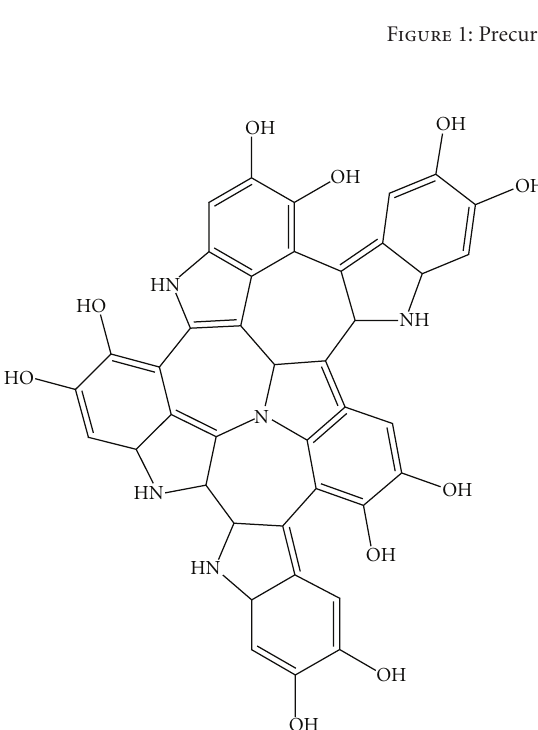
Figure 2: Model of DHI melanin oligomerization.